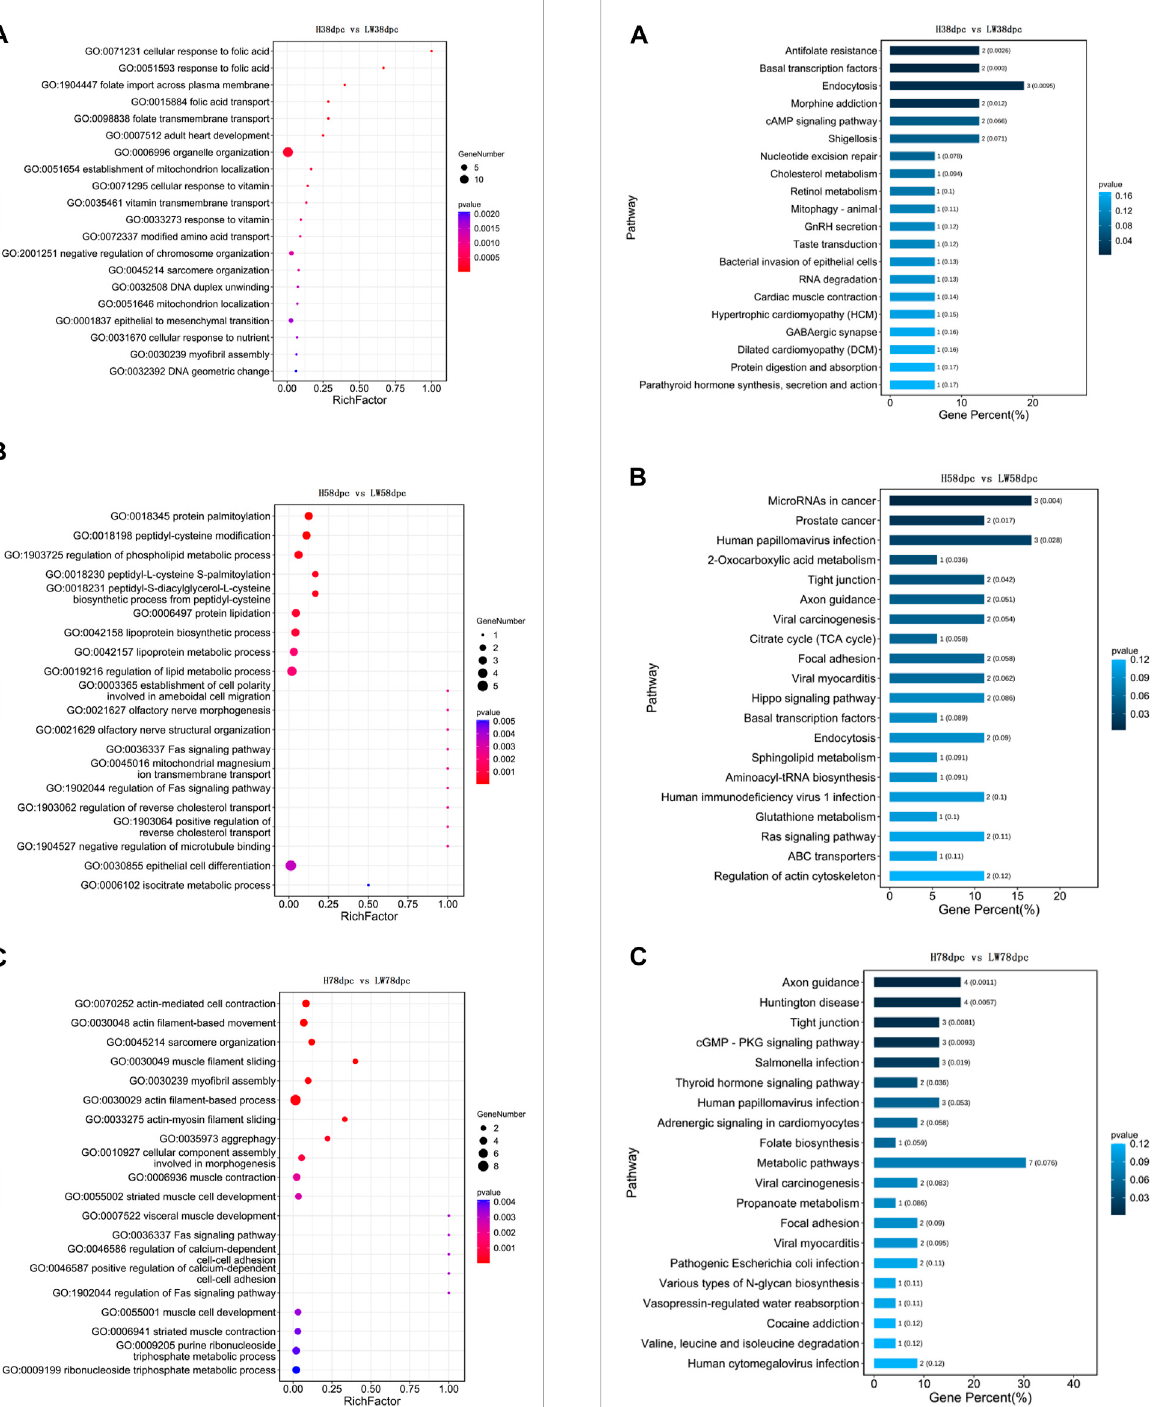
FIGURE 3 GO enrichment analyses based on parent genes of differential circRNAs at 38 dpc (A) , 58 dpc (B) , and 78 dpc (C) .